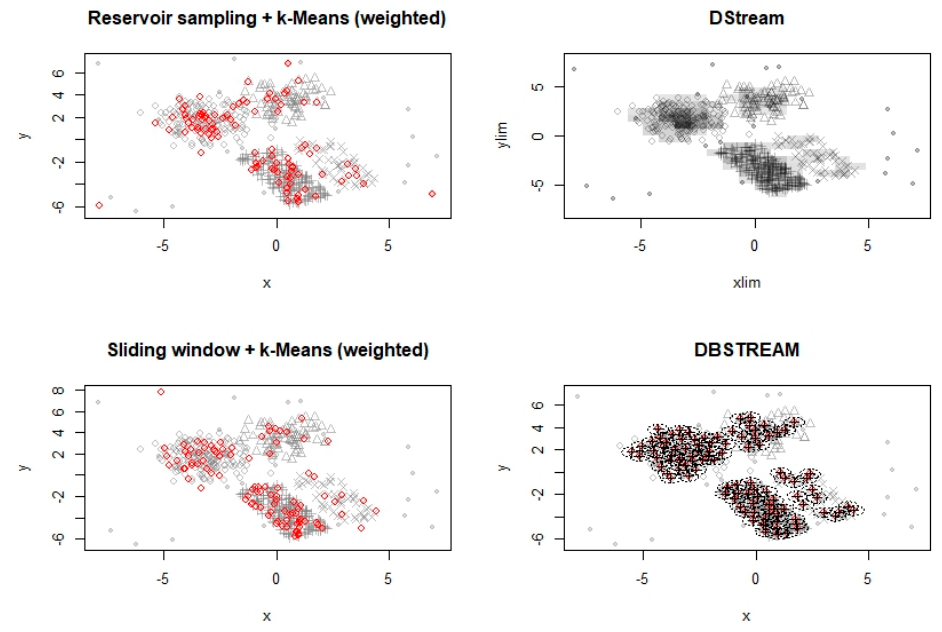
Figure 4. Micro-cluster assignment areas for different data stream clustering algorithms.